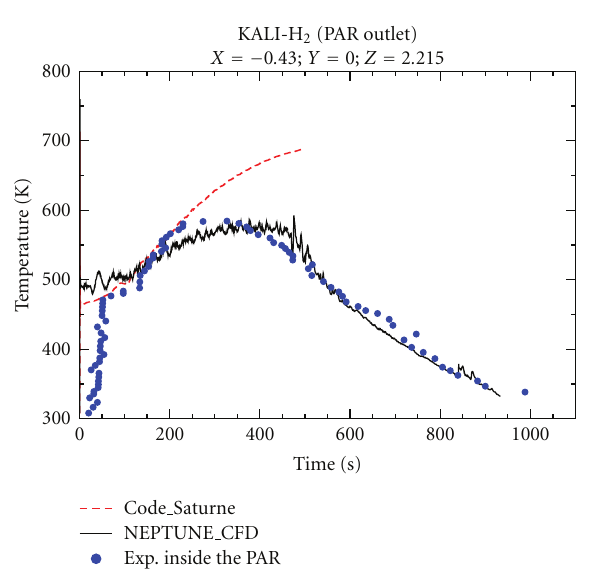
Figure 12: H 2 mass fraction at outlet of the PAR.